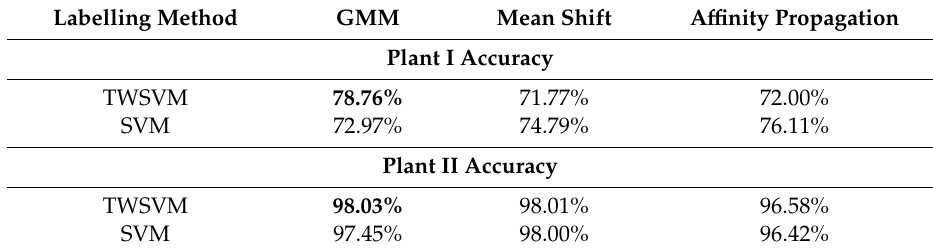
Table 5. Accuracy comparison between SVM vs. TWSVM with Decision Trees for K-means clustering as the initial label